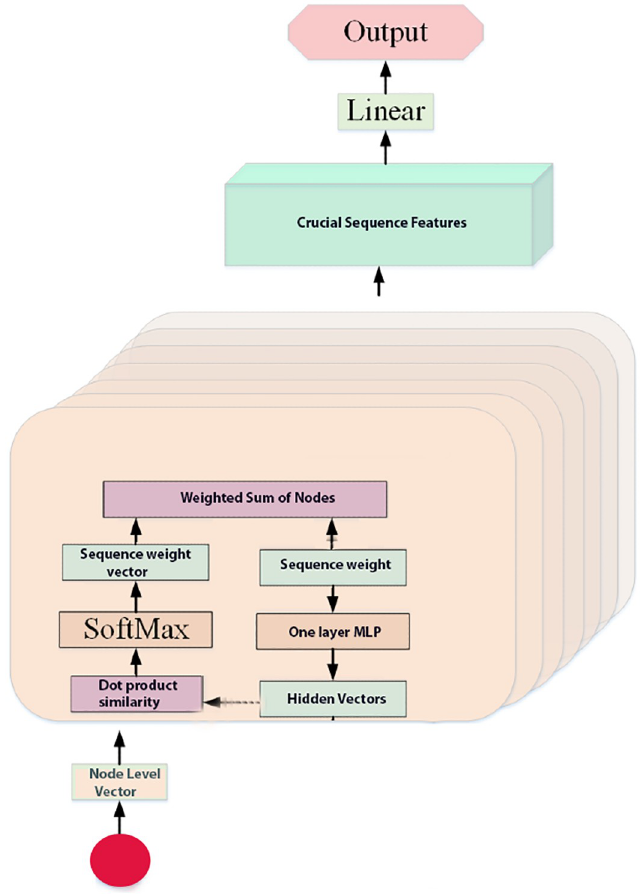
Fig 3. The process of attention